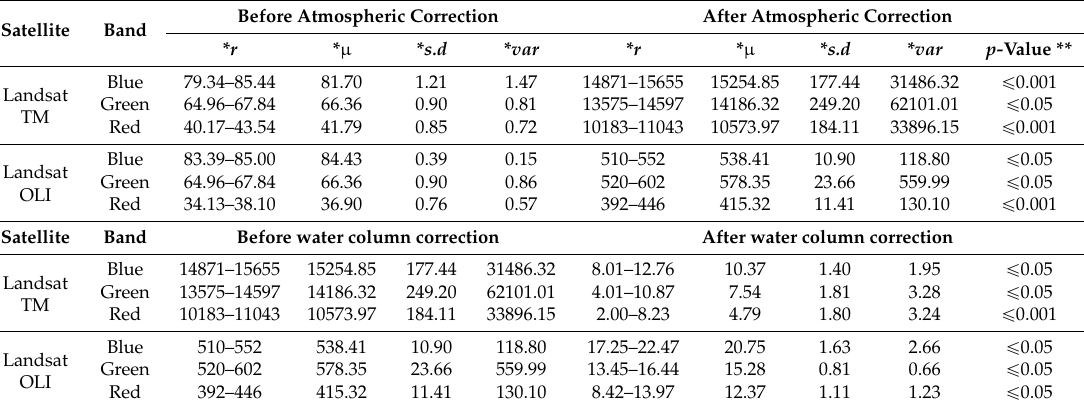
Table 4. Statistics of before and after atmospheric correction and water column